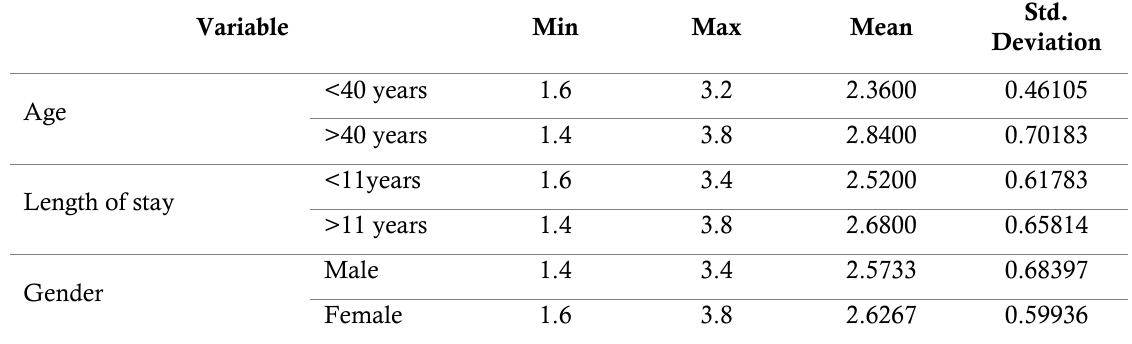
Table 1 Descriptive Statistical Test Results for Behavioral Factors in Household Effluent